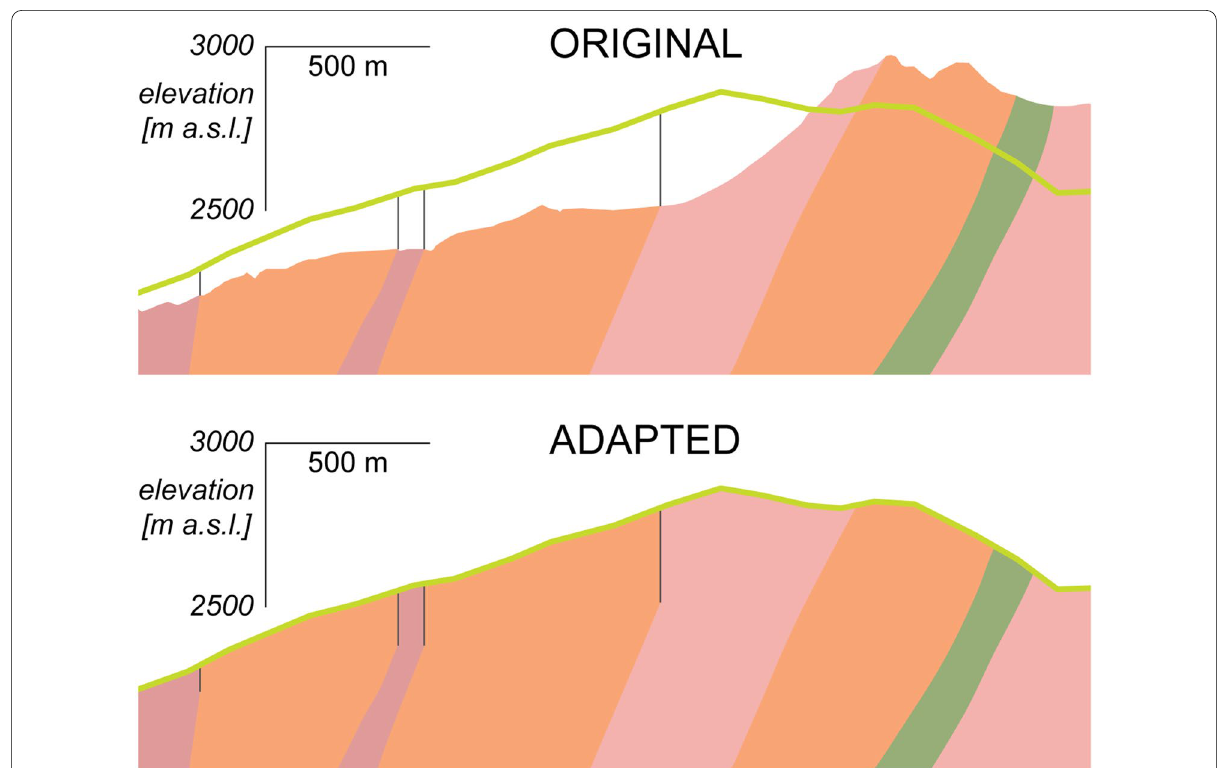
Fig. 3 Adaptation of the original GBT geological model profile to the reference model line’s topography (green line). One of the following two steps is performed. If the target topography is higher than the original, lithological boundaries are vertically upward continued (thin black lines), and the geological units (coloured) extended and “filled” with the same lithology (left side of the sample section). In the opposite case, the units are simply truncated at the target topography (right side of the sample section). This example is shown without vertical exaggeration, above 2000 m elevation, and is located at the centre of the profile; the highest peak in the original profile is near Piz Vatgira (2982 m), the highest peak along the reference model line is near the 2888 m peak west of Piz Gannaretsch